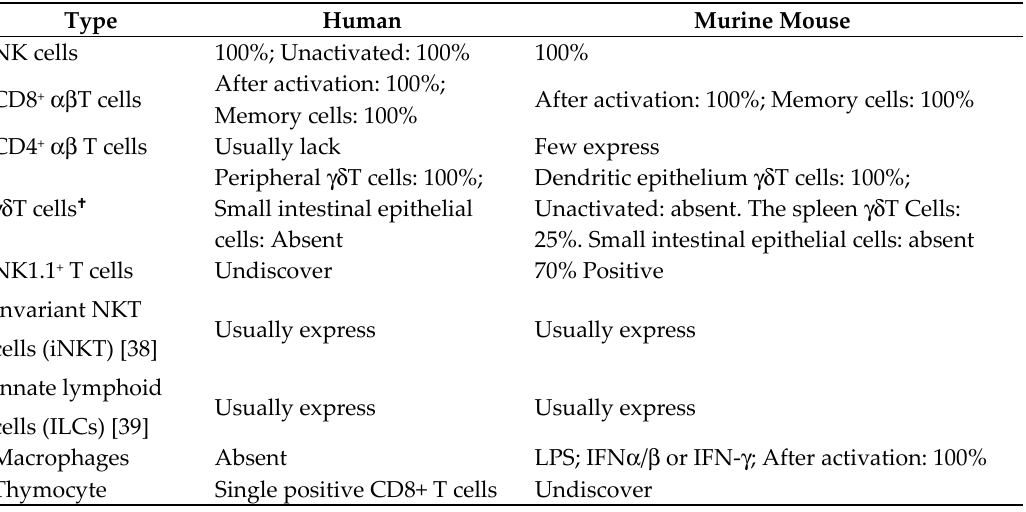
Figure 3. The gene structure of human NKG2D. The gene structure of human NKG2D is composed of 10 exons and 9 introns. Exons 2–4 encode the intracellular and transmembrane domain. Exons 5–8 encode the domain, which is prominent in the extracellular and can combine with a ligand. Table 2. The di ff erential expression of NKG2D in humans and mice.